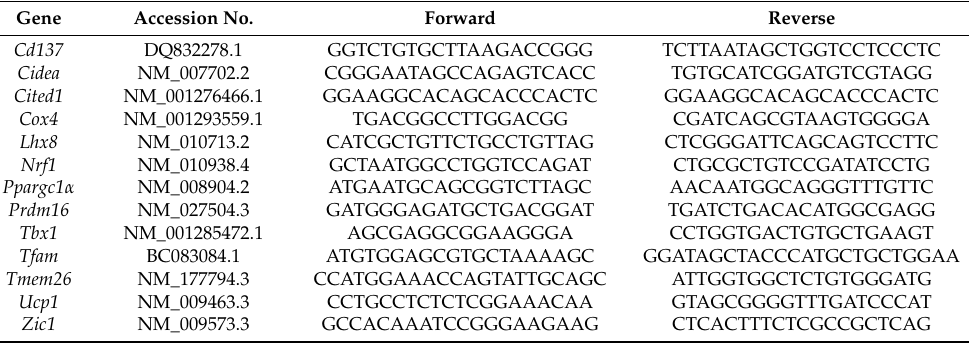
Table 1. List of primers used for real-time quantitative